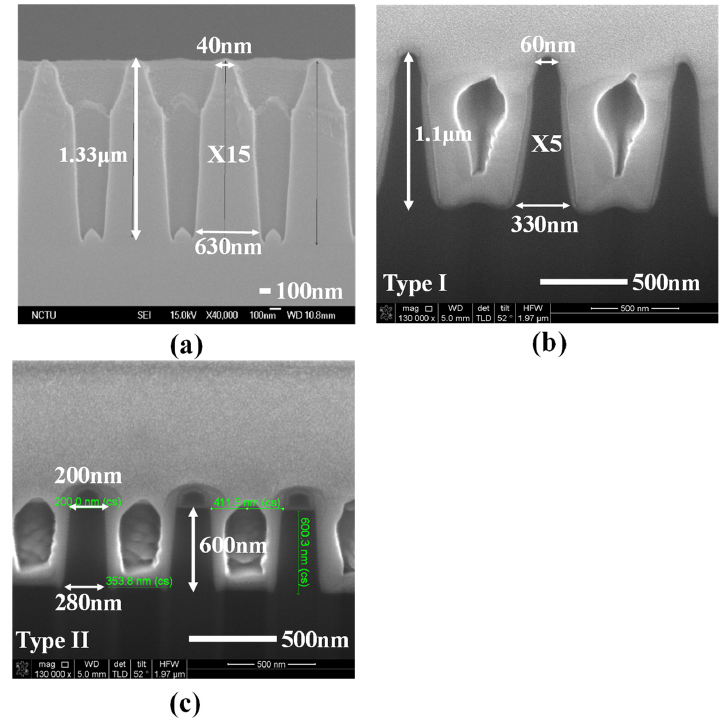
Figure 2. The cross-sectional view of prepared optical structures. The multi-functional folded electrode (MFFE), Type I, and Type II are shown in ( a – c ), respectively (“X15” and “X5” marked in ( a , b ), respectively, are the width ratio of the bottom silicon to the top one, indicating the different tilt in the prepared structures).